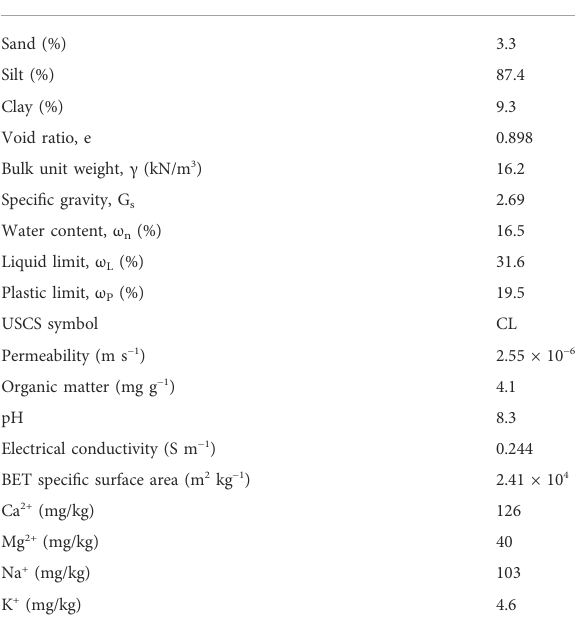
TABLE 1 Physicochemical properties of the